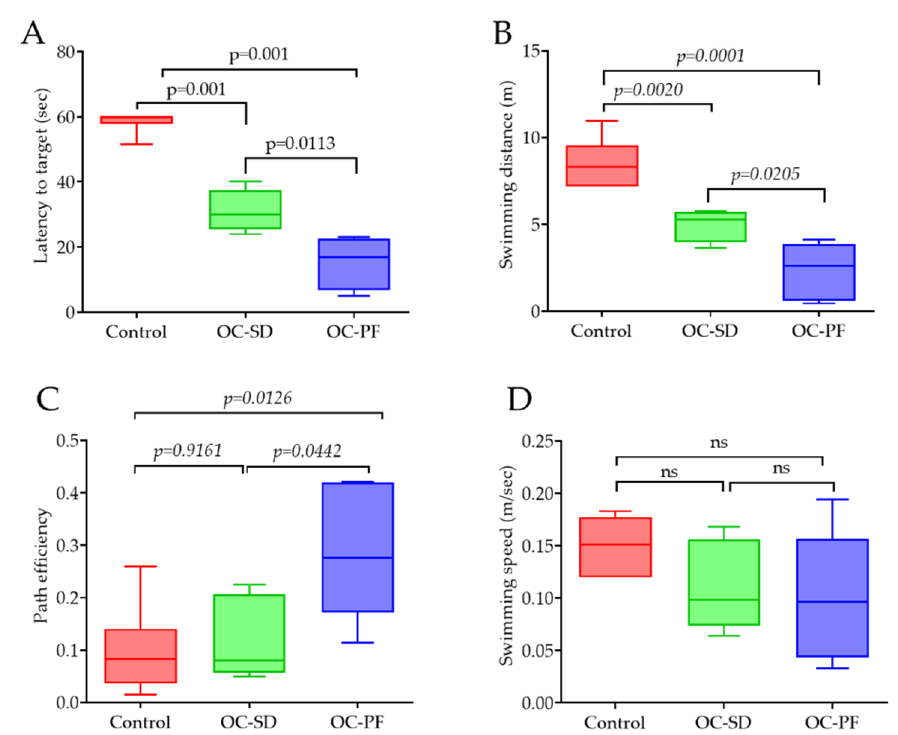
Figure 2. Spatial learning and memory ability effects of OC-PF and OC-SD on 5xFAD mice using the Morris Water Maze (MWM) model. ( A ) Latency to target, F (2, 15) = 84.93, p < 0.05. ( B ) Swimming distance, F (2, 15) = 30.51, p < 0.05. ( C ) Path efficiency, F (2, 15) = 6.072, p < 0.05. ( D ) Swimming speed, F (2, 15) = 1.924, “ns”: non-significant, for 5xFAD mice in MWM task. Data analyzed using one